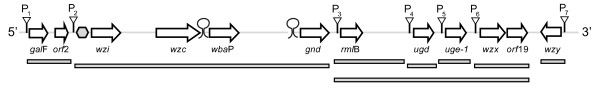
Model of regulation in the K. pneumoniae Kp13 cps cluster. Only selected genes are shown. The promoters are depicted as upside-down triangles, and the JUMPStart element is shown as a hexagon. The rectangles under each cluster represent transcriptional units, and the stems are possible Rho-independent attenuators. P3 could either drive the transcription of rmlB through orf19 or there could be other promoters (P4, P5 or P6). The possible transcriptional units are depicted.